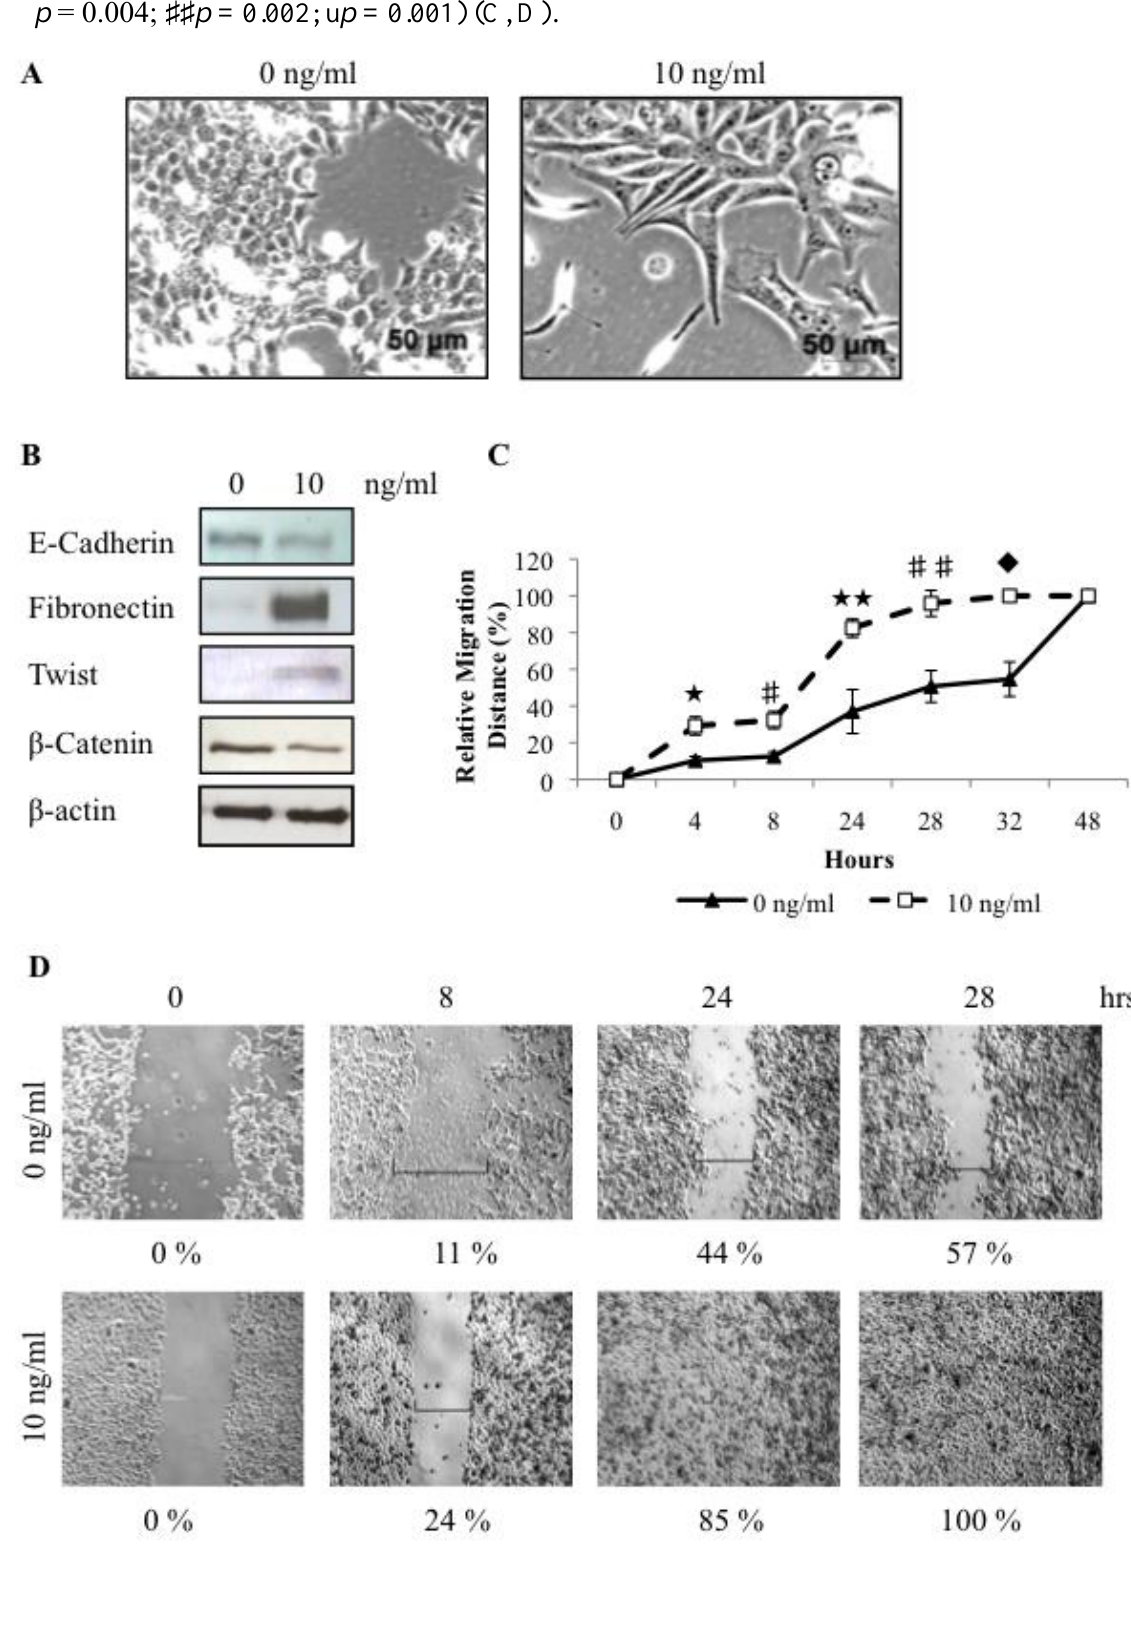
Figure 4. Treatment of canine mammary carcinoma cells with TGF β can induce an epithelial to mesenchymal transition, as indicated by changes in cell morphology (A), protein expression levels (B), and increased migration ability ( ★ p = 0.018; ♯ p = 0.014; ★★ p = 0.004; ♯♯ p = 0.002; u p = 0.001) (C,